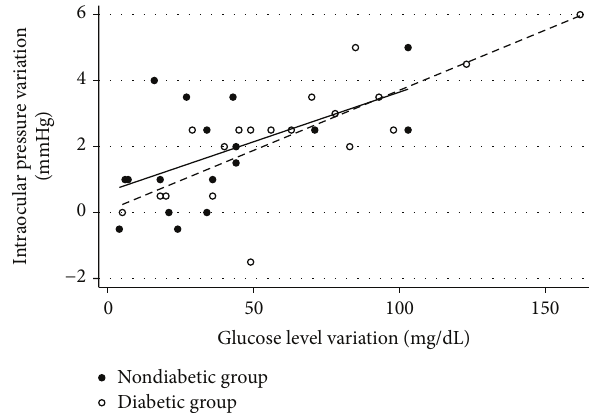
Figure 2: Scatter plot showing the association between IOP varia- tion and glucose levels variation in both groups.